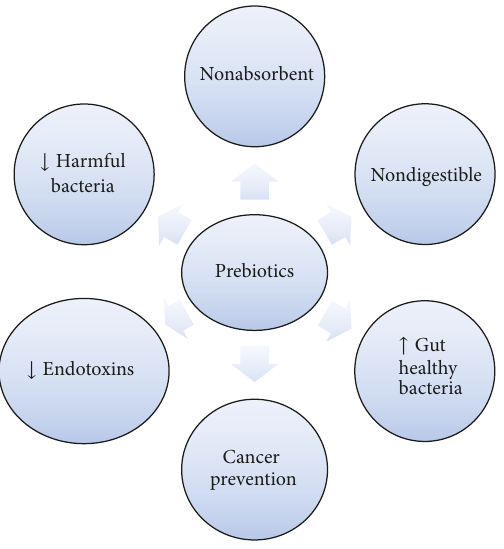
Figure 4: Properties of